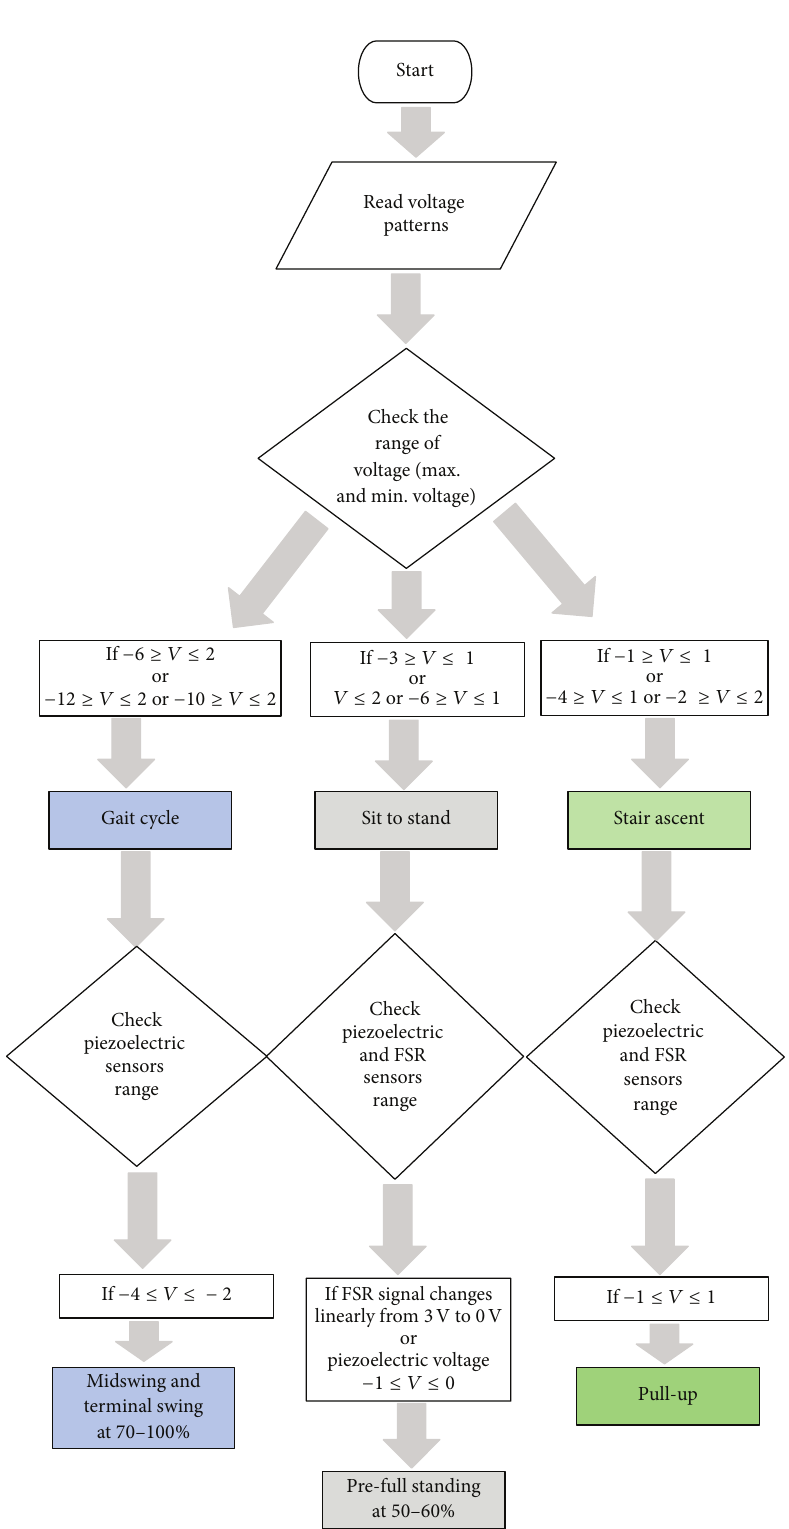
Figure 10: Flow chart presents the identification process of the knee state by consideration the range of voltage of piezoelectric